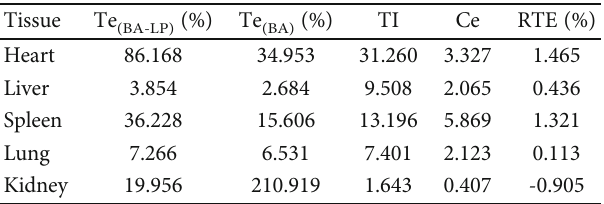
Table 5: The targeting parameters in tissues of normal mice after intravenous injection of BA-LP and BA.